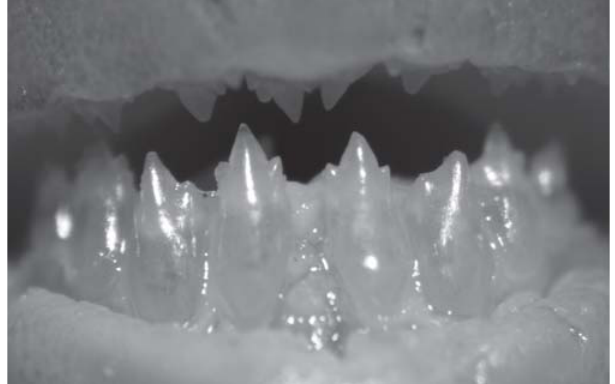
Fig. 1. Frontal view of dentary teeth of Astyanax henseli , MNRJ 22214, 70.2 mm SL, rio Forqueta, tributary of the rio Taquari, Rio Grande do Sul,